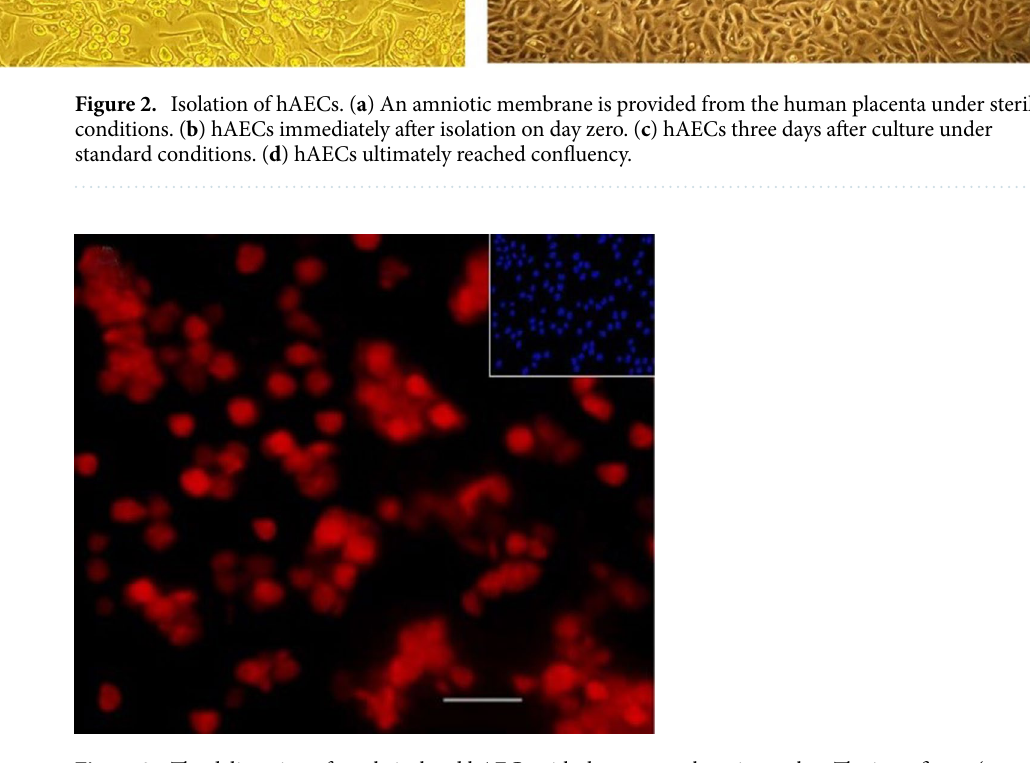
Figure 3. The delineation of newly isolated hAECs with the pan-cytokeratin marker. The inset figure (upper right) shows DAPI nuclear staining of the same field. Scale bar: 50